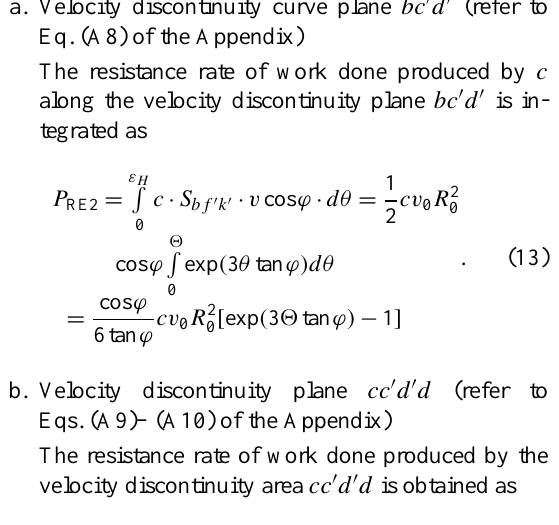
a. Velocity discontinuity curve plane bc (cid:48) d (cid:48) (refer